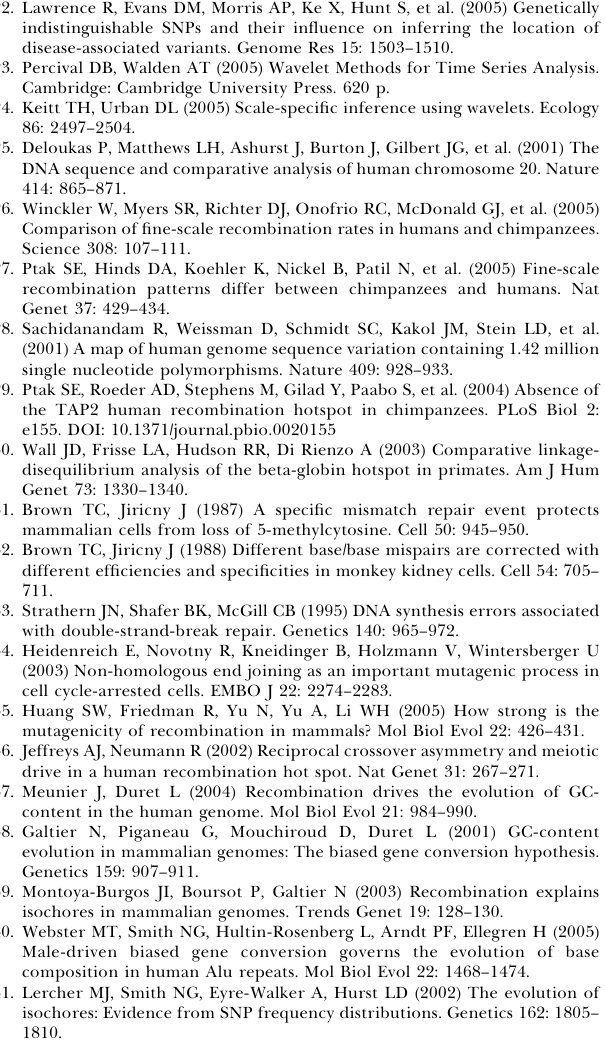
Figure S2. Estimates of the Strength of Gene Conversion from Allele Frequency Distributions Mutations were classified into four categories (GC ! GC, GC ! AT, AT ! AT, and AT ! GC on the basis of comparison of the human alleles with that of the Chimpanzee reference sequence). For each class we calculated the likelihood for a grid of values of the strength of gene conversion (the parameter G ¼ 4 N e ct ) and average read depth in the SNP ascertainment panel (modeled as a trimmed Poisson distribu- tion). The heat chart represents the likelihood surface (white is the highest likelihood), with the cross-hair showing the joint maximum likelihood estimates and the red points showing the marginal maximum likelihood estimates for G conditioning on values of average read depth. Contour rings marks the estimated confidence intervals (calculated by assuming twice the difference in log likelihood between models is approximately v 2 distributed with 2 degrees of freedom) for p -values of 0.05, (solid line), 0.01, 0.001, and 0.0001, respectively. Figure S3. Maximum Likelihood Estimates of the Strength of Gene Conversion ( G ¼ 4 N e ct ) from SNPs in the African-American Population Sample for Each Quintile of the Recombination Rate In this analysis we assume that G AT ! GC ¼(cid:1) G GC ! AT . Estimates are shown both including (A) and excluding (B) potential CpG mutations. Also shown are estimates of G for SNPs in quintiles of GC content [(C) note that recombination and GC content are strongly correlated]. Solid and dashed lines indicate maximum likelihood estimates